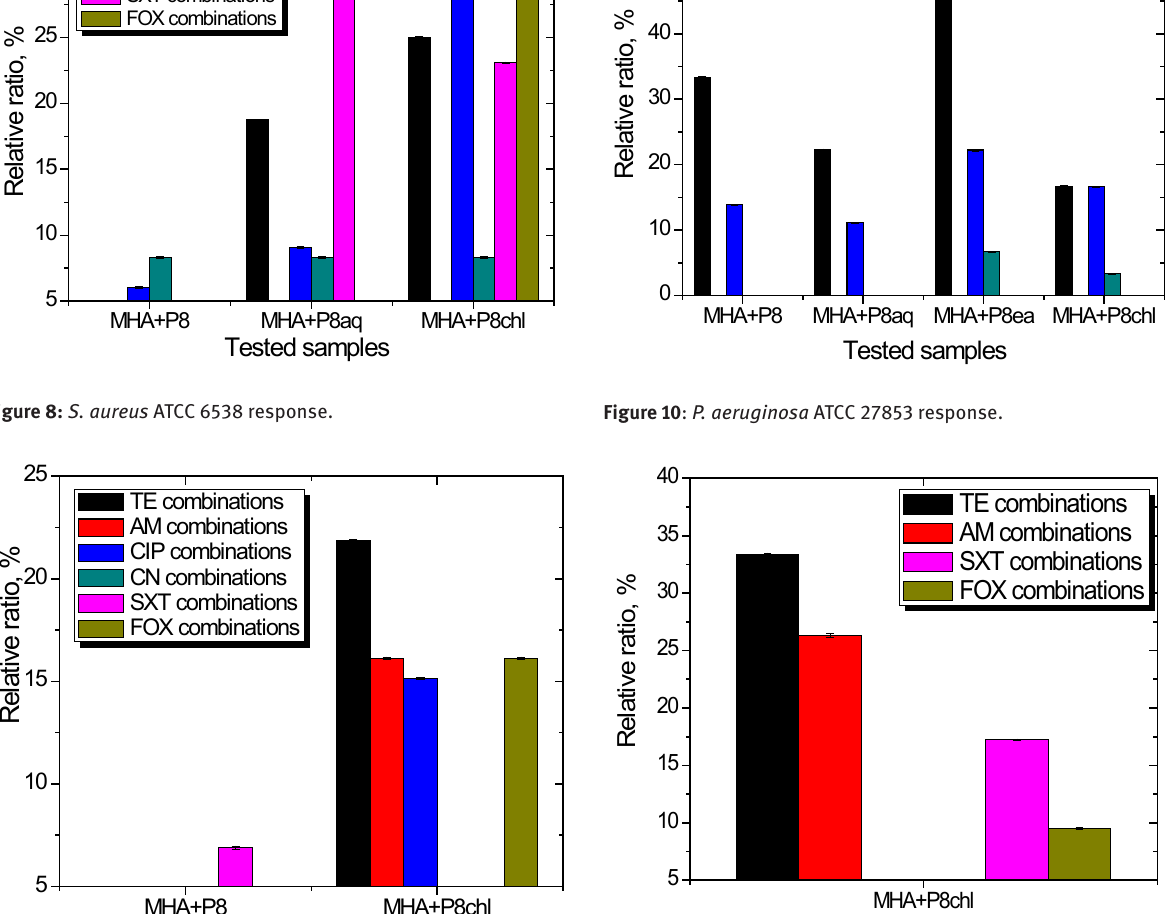
Figure 9: S. aureus ATCC 25923 response.